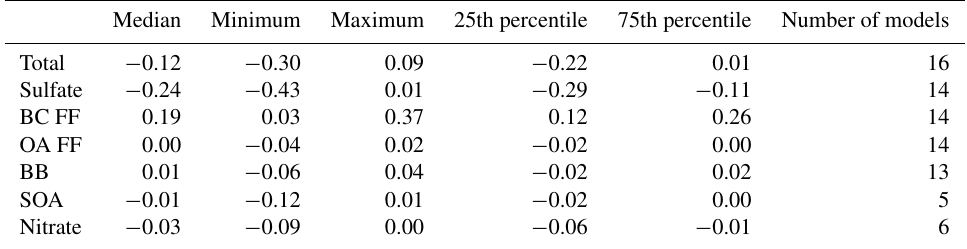
Table 5. Annual mean Arctic (60–90 ◦ N) DAE AeroCom Phase II model median, model range (minimum and maximum), and the 25th / 75th percentile. The number of models for each species is given in the rightmost column. BC FF is BC from fossil fuel and biofuel emissions and OA FF is OA from fossil fuel and biofuel emissions. BB is BC and AO combined from biomass burning